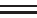
ˆ f TABLE V. Estimation of 0 for the LHC main dipoles and quadrupoles and comparison with numerical fit of the simulated data (assuming single pole